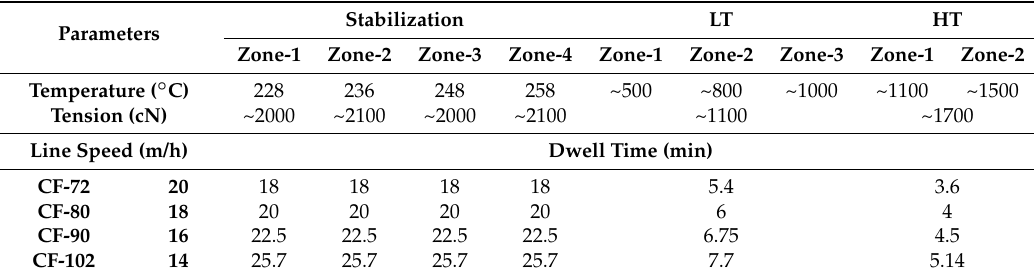
Figure 1. Schematic representation of the carbon fibre production line at Carbon Nexus, Deakin University. Table 2. Process specifications for sample